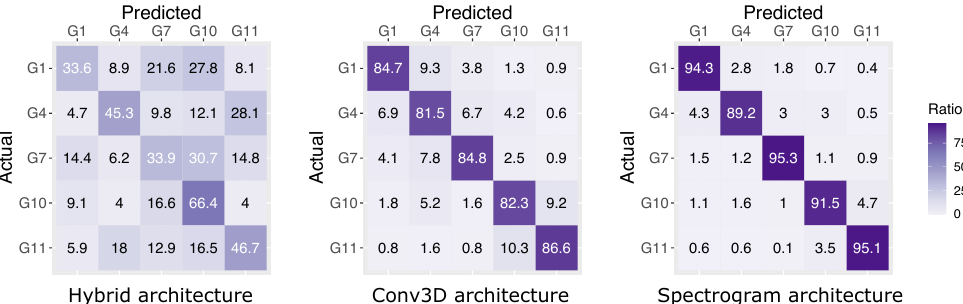
Figure 11. Confusion matrix for the reduced gesture set (5